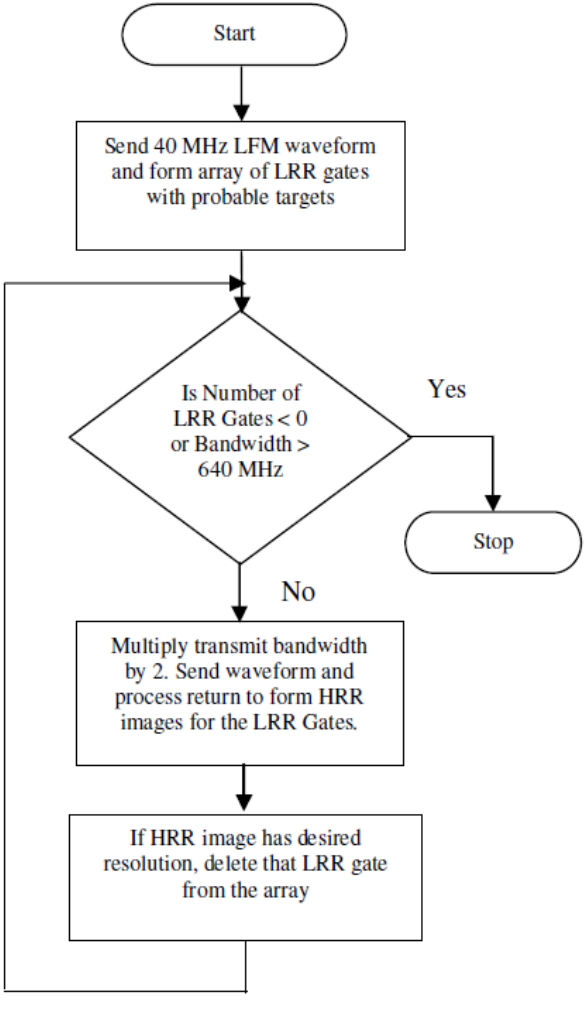
Figure 2. Flowchart for operation of multimodal radar in staring